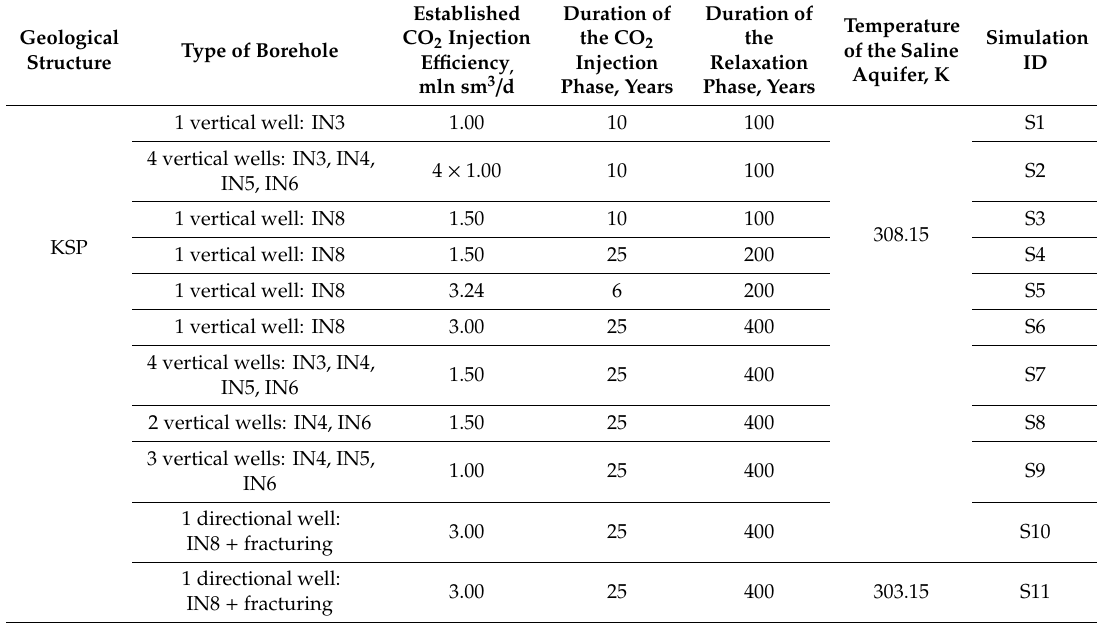
Table 6. List of considered simulation variants of CO 2 injection into geological